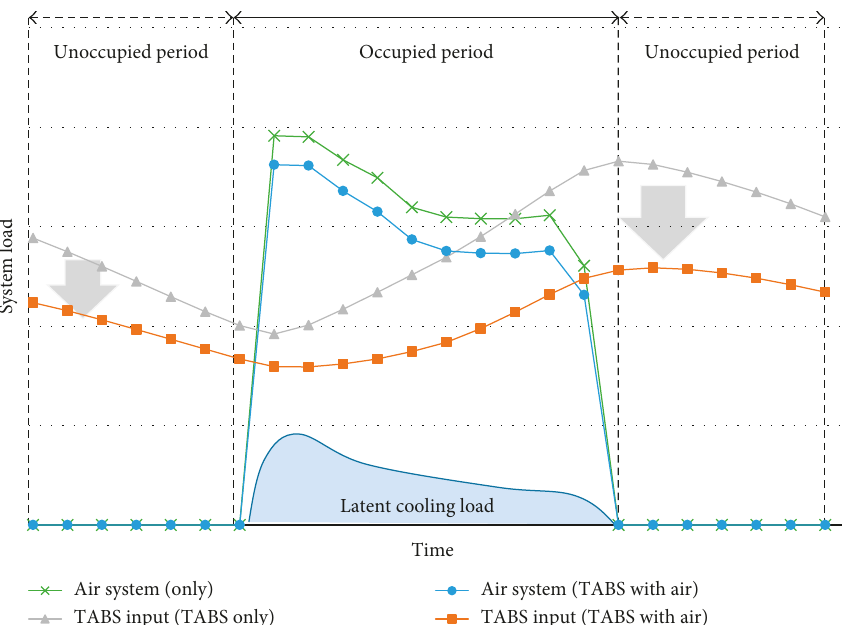
Figure 2: Changes in performance of the thermally activated building system integrated with the air system.